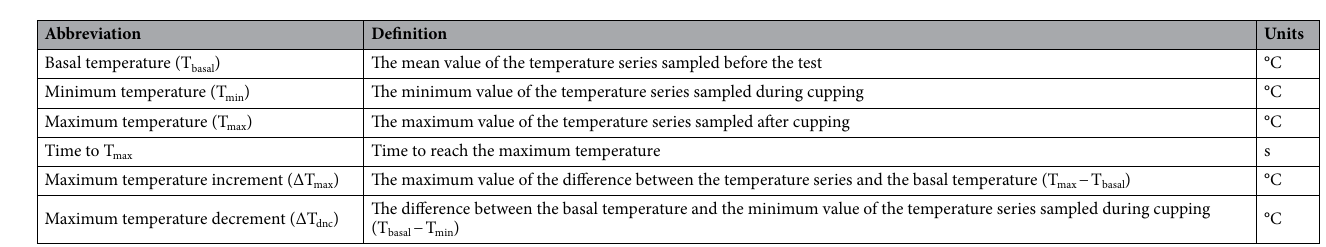
Figure 4. Time-dependent skin temperature changes induced by negative pressure (− 0.04 MPa) in a representative subject. The black dots represent the temperature series sampled in the experiment. The blue curve is obtained from these data using smooth spline fitting, and is divided into three stages by the red dash- dotted lines: basal stage, cupping stage and recovery stage. In these three stages, the three parameters (T basal , T min , and T max ) indicated by the arrows were used to quantify the dynamic change limits of skin temperature. Table 2 shows the detailed definition of these parameters.